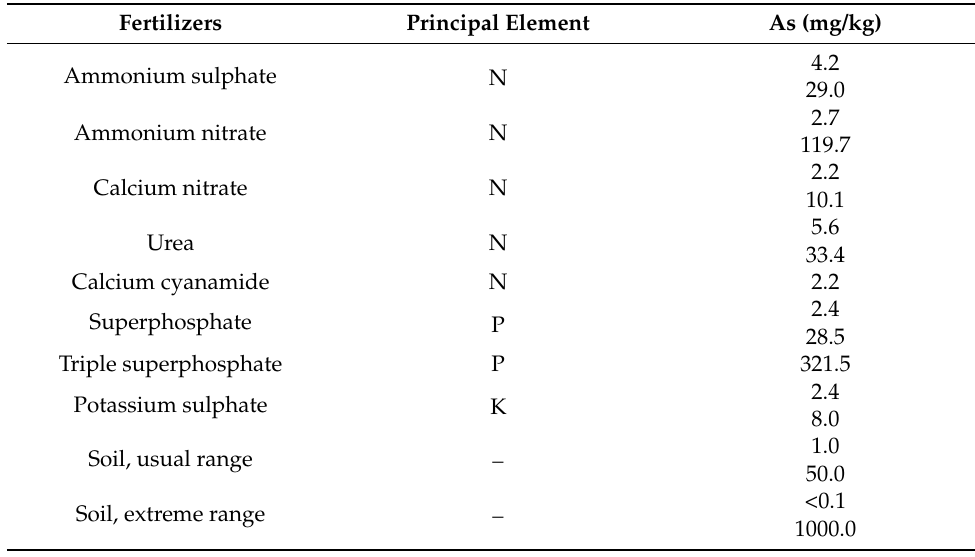
Table 5. Range (first line, minimum or unique value; second line, maximum value) of As contents (mg/kg) of investigated fertilizers